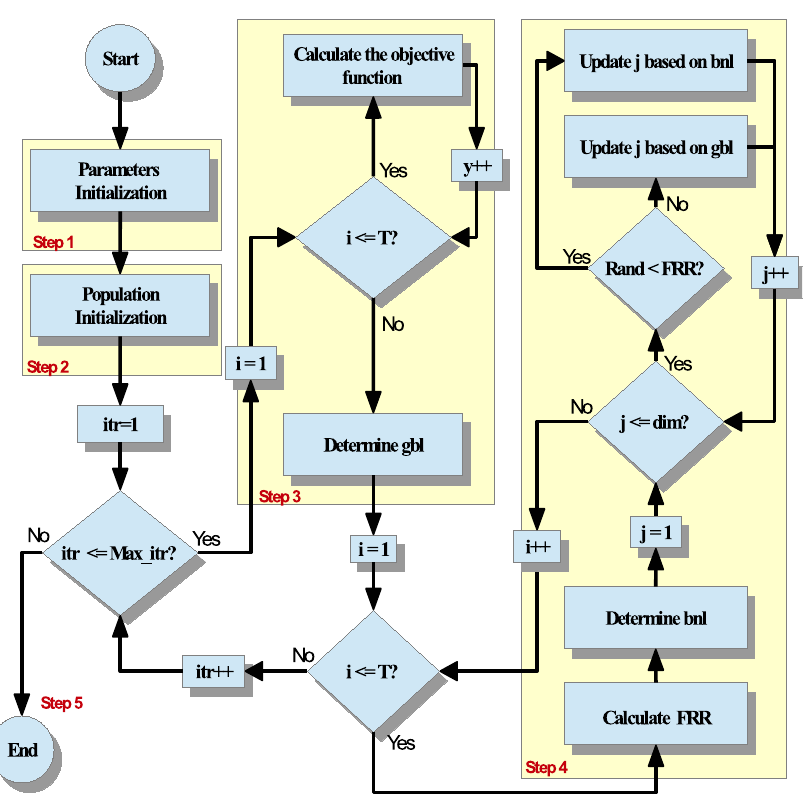
Figure 6. Lemur Optimizer